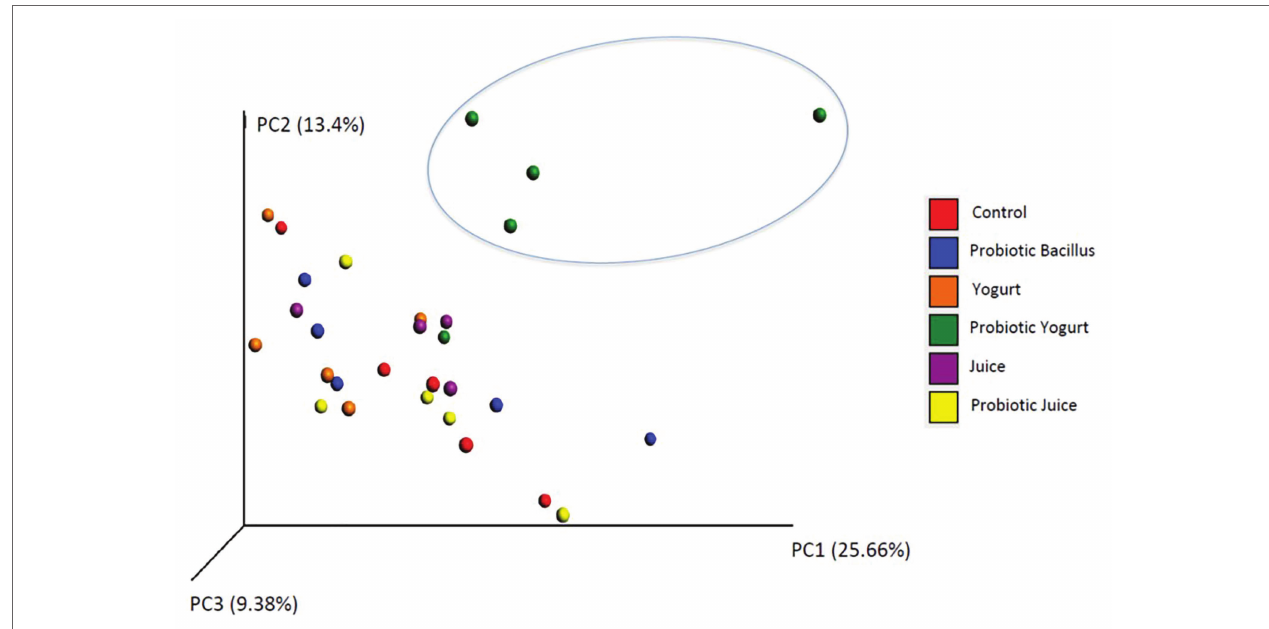
FIGURE 1 | Principal coordinate analysis of jackknifed unweighted UniFrac distances for the 16S rRNA gene sequence data. Groups were as follows: Control: received distilled water; Juice: received orange juice; Yogurt: received yogurt; probiotic Bacillus : received B. coagulans GBI-30 6086 suspended in distilled water;